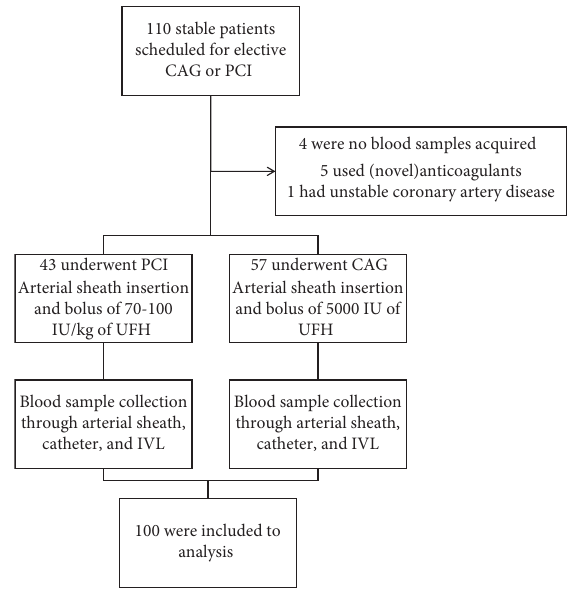
Figure 1: Screening, procedure and analysis ∗ . CAG � coronary an- giography; PCI � percutaneous intervention; IU � International Units; UFH � unfractionated heparin; IVL � intravenous line; ∗ patients were eligible for inclusion when it was expected that the scheduled pro- cedure would be accomplished with a single bolus of heparin. At the start of the procedures, an injection of UFH was administered over the arterial sheath. Patients who underwent CAG or PCI received, re- spectively, 5000IU or 70–100IU/kg of UFH. At the end of the procedure, blood samples from the arterial sheath, catheter, and IVL were collected and the ACT measurement was performed. Table 1: Baseline characteristics of the study